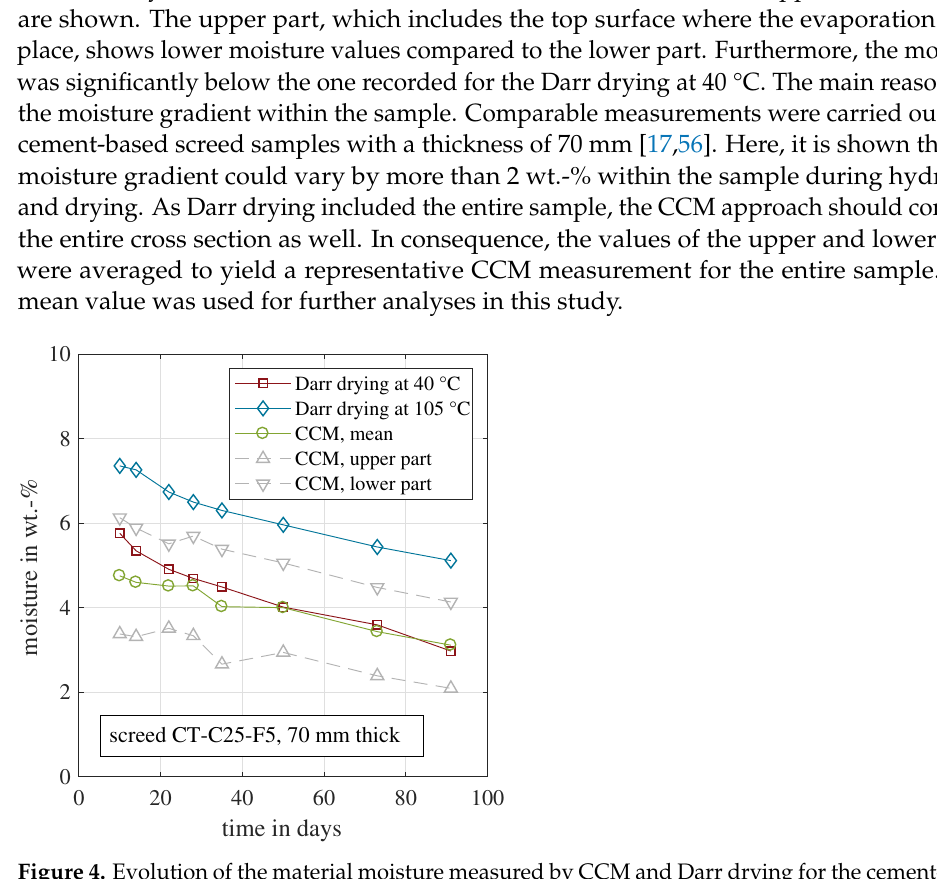
Figure 4. Evolution of the material moisture measured by CCM and Darr drying for the cement-based samples